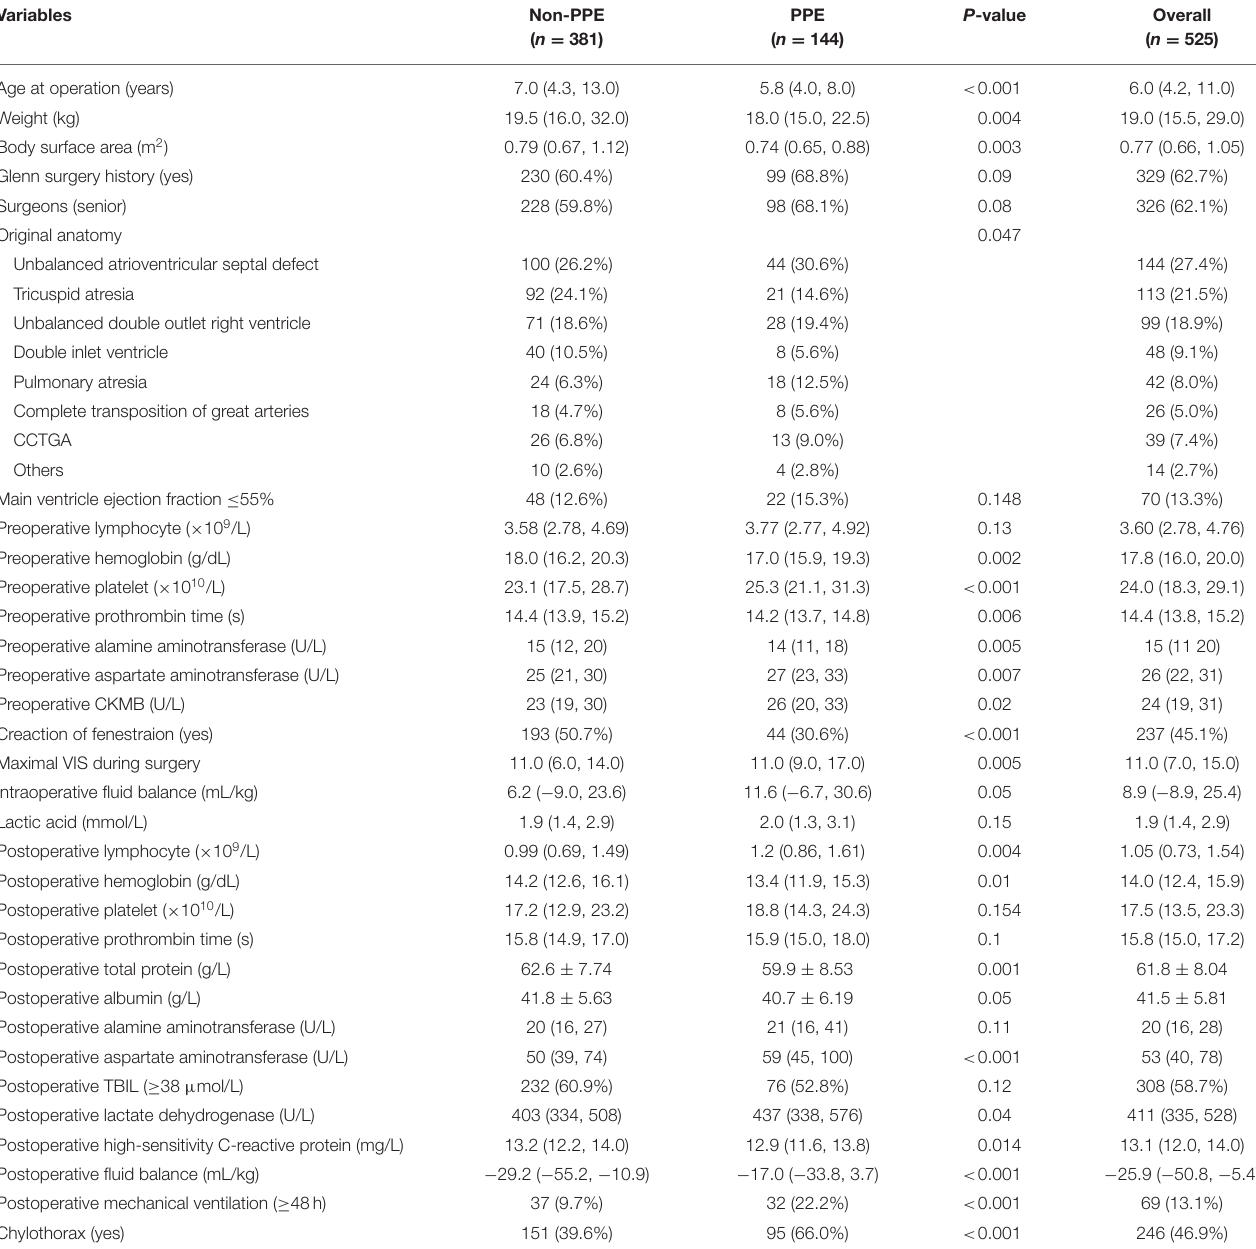
TABLE 2 | The perioperative characteristics of the study patients with p < 0.15 in univariate